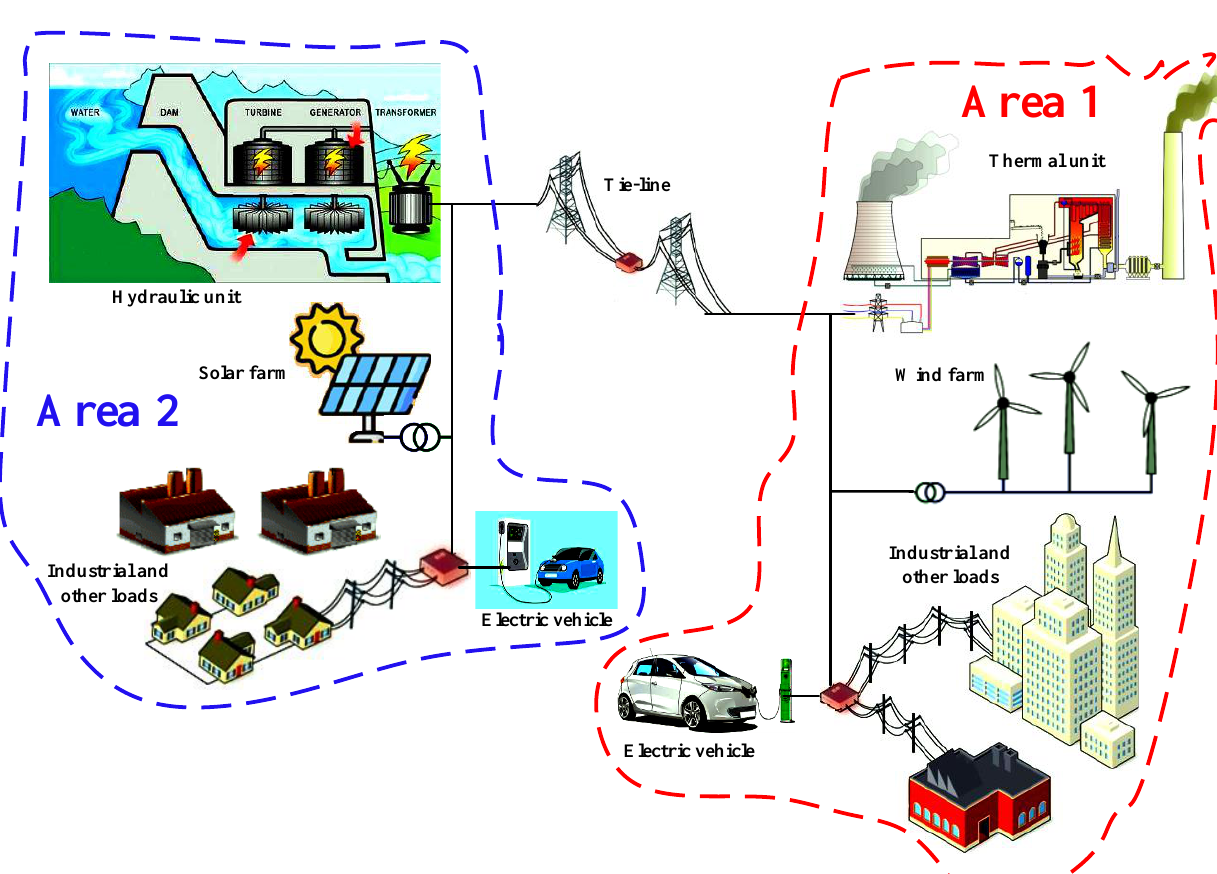
Figure 13. Hybrid two-area power system under study.